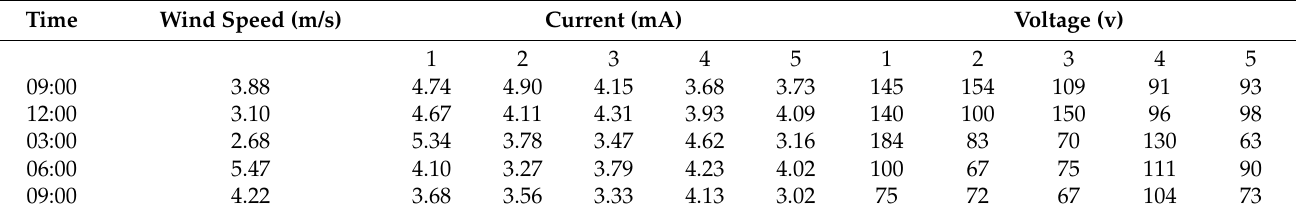
Table 4. Experimental readings of voltage and current for different rotors starting from bottom to top.